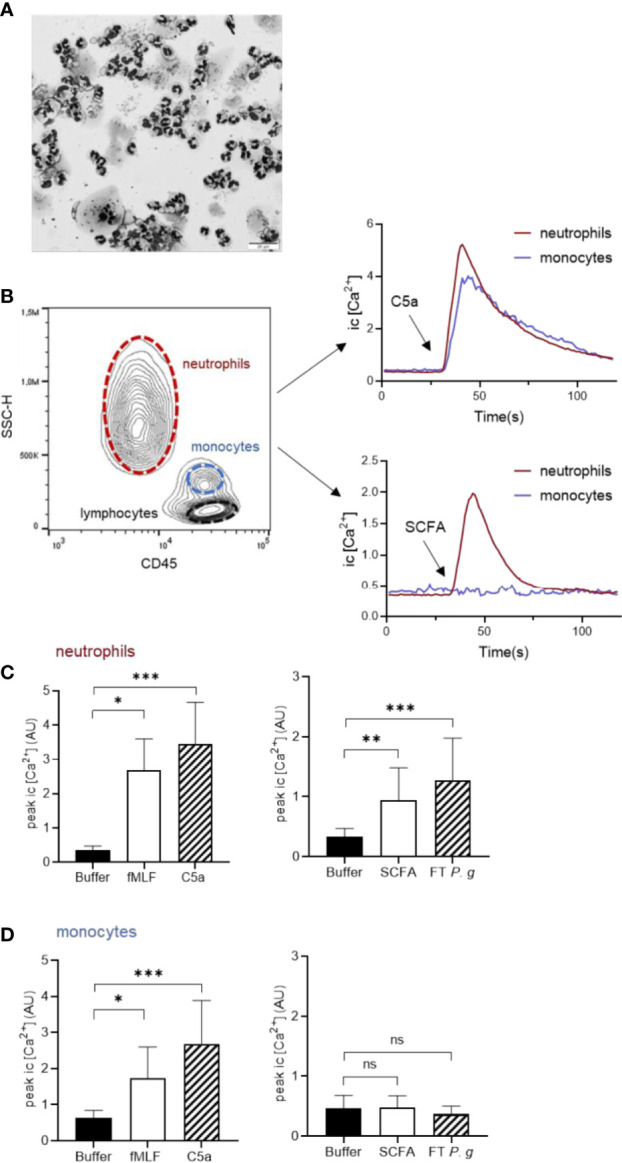
SCFAs released by P. gingivalis activate neutrophils, but not monocytes. (A) GCF samples from patients diagnosed with periodontitis were cytospun and stained with Giemsa and May-Grünwald and were evaluated microscopically as described earlier (Dahlstrand Rudin et al., 2020). Micrograph shows abundant neutrophils, a few epithelial cells and complete absence of mononuclear cells. The scale bar represents 20 µm. (B) Human buffy-coat leukocytes, costained with Ca2+ dyes Fluo-3 and Fura Red and anti-CD45 antibody, were stimulated with fMLF (1 nM), C5a (100 ng/ml), SCFA, FT fraction of P. gingivalis 381 supernatant, or buffer and intracellular Ca2+ signals were monitored by flow-cytometry. Neutrophils and monocytes were gated based on CD45 and side-scatter properties and analyzed separately. Graphs show the neutrophil and monocyte intracellular Ca2+ responses after stimulation with C5a, and SCFA from one representative experiment. Graphs show peak values (mean + SD, n = 5-9) of Ca2+ responses for neutrophils (C) and monocytes (D), respectively after stimulation with fMLF, C5a, SCFAs, FT P. g or buffer. Kruskal-Wallis test followed by Dunn´s multiple comparison test was used for statistical analyses ns >0.05, *<0.05, **< 0.01, ***< 0.001.